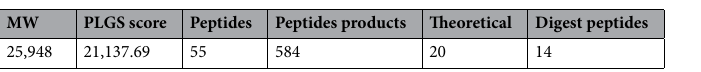
Table 1. TOF/TOF mass spectra database